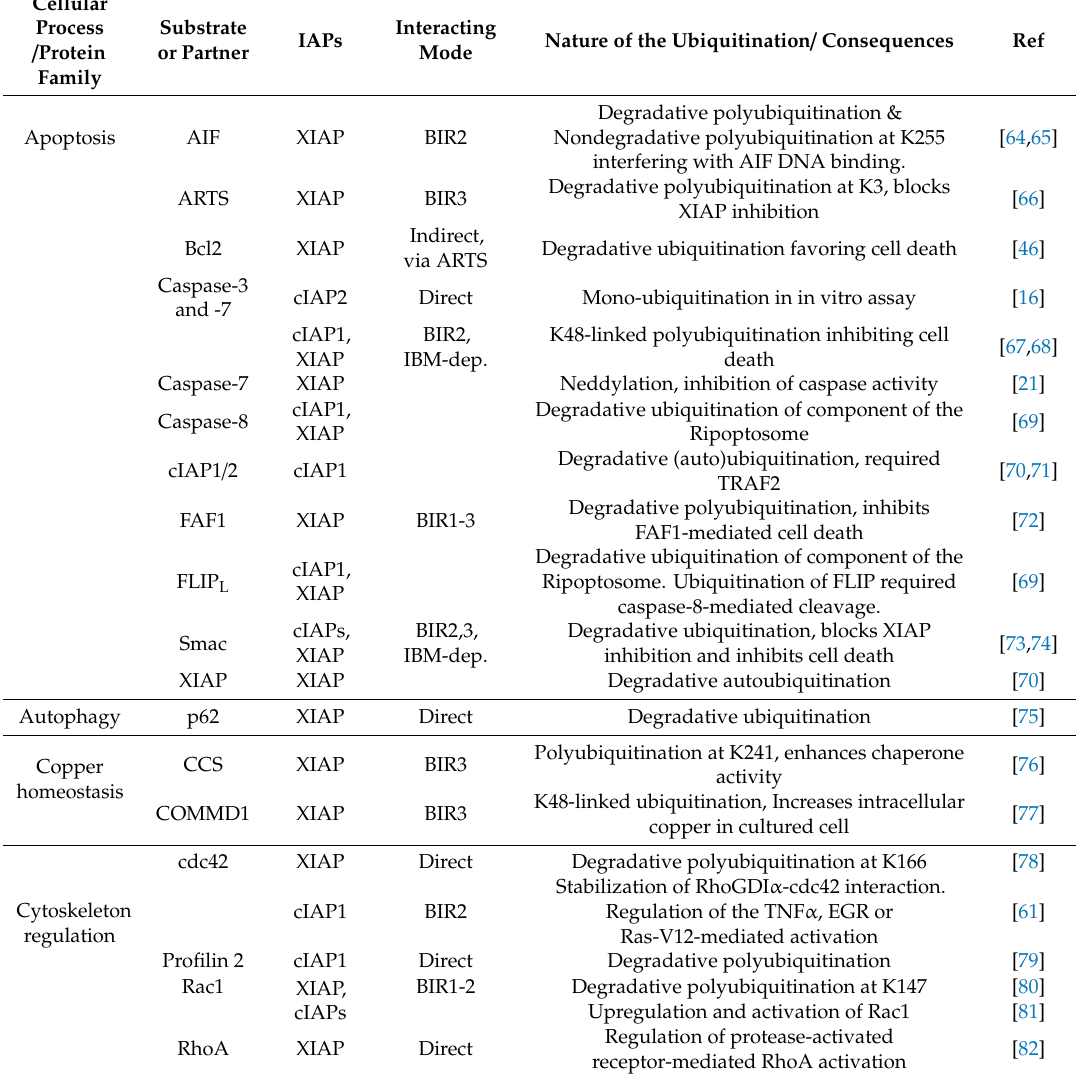
Table 1. IAP ubiquitination